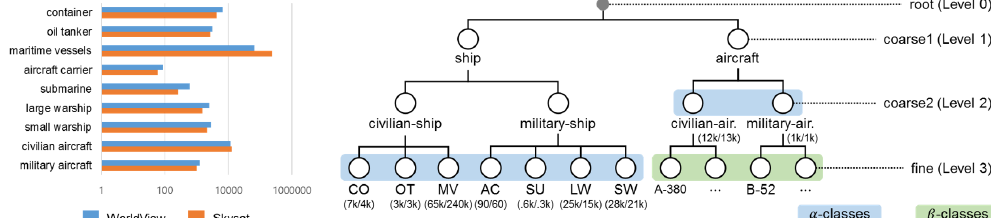
Figure 7. Left: Distribution of objects over categories. Right: Four-depth class hierarchy of our own datasets: root at level 0 (not used), coarse1 at level 1, coarse2 at level 2, and fine at level 3. The two numbers in parentheses written below each category name mean the object counts in WorldView-3 and SkySat dataset, respectively. Only some objects are annotated as categories belonging to incomplete -categories as their fine